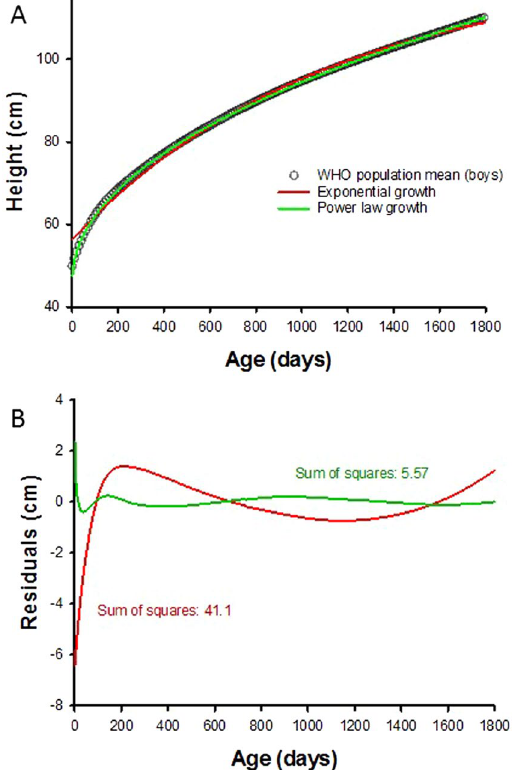
Figure 1. ( A ) Comparison of the fits of the exponential (red) and power law (green) growth models to the population mean of boy’s height in the World Health Organization (WHO) data set. ( B ) Comparison of the sum of square residuals of the exponential and power law model fits. Note that the error of the exponential model is more than 7 times larger than that of the power law